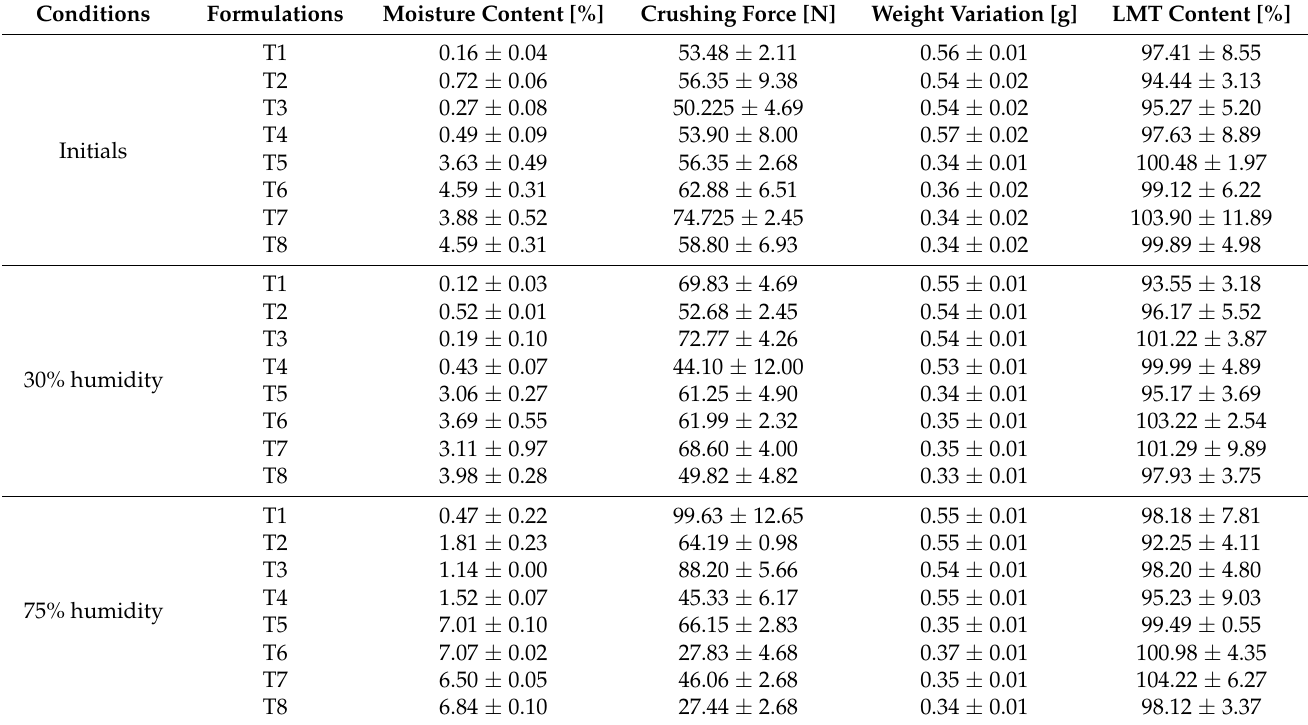
Table 2. Test values for moisture content in LMT tablet formulations (T1–T8), resistance to crushing and weight variation (results are shown as mean value ± standard